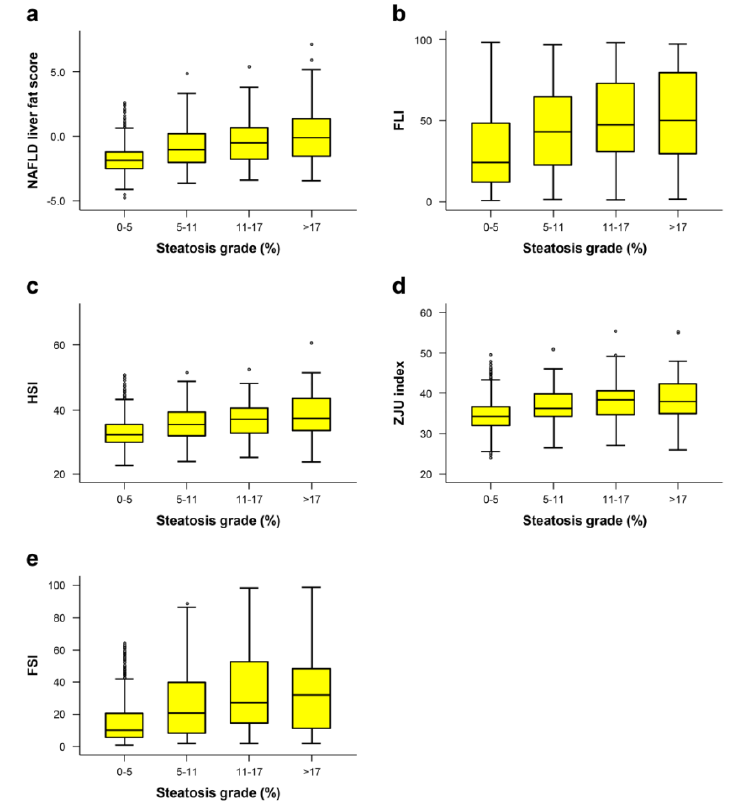
Figure 3. Box plot of each prediction model: ( a ) NAFLD liver fat score, ( b ) fatty liver index (FLI), ( c ) hepatic steatosis index (HSI), ( d ) ZJU index, and ( e ) Framingham steatosis index (FSI)) for predicting fatty liver according to the degree of hepatic steatosis. The yellow box represents the interquartile range and the black line across the box indicates the median. “Whiskers” are black lines that extend from the box to the highest and lowest values, excluding outliers